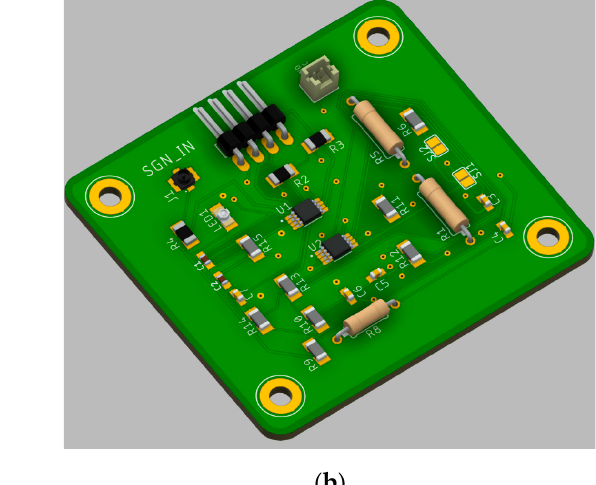
Figure 29. Waveforms of the output signal V out (yellow trace) and the filtered output signal V out, filtered (cyan trace) in response to the flexural ( a ) and impulsive ( b ) solicitations.